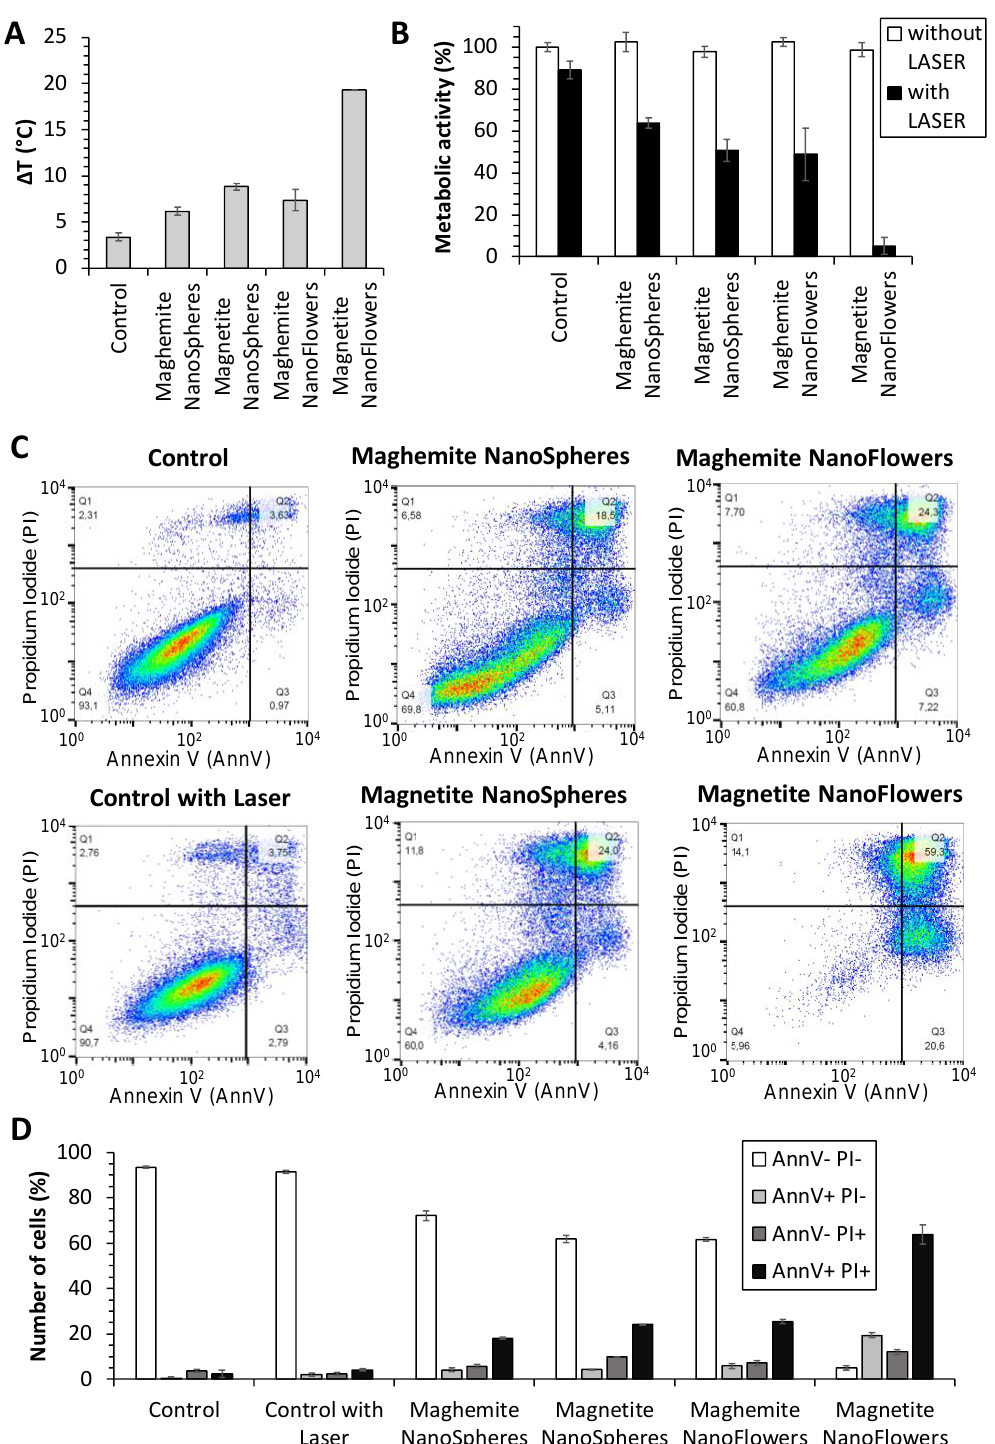
Figure 6. Characterization of the photothermal therapy carried out on PC3 prostatic cancer cells doped with the 4 types of MNPs. Temperature increase achieved in the cell suspensions treated with a 1064 nm laser at a power density of 0.3 W cm − 2 for 10 min ( A ), and the corresponding outcomes, 24 h after the treatment, analyzed by a metabolic / cytotoxicity test ( B ) with and without the laser irradiation. Annexin V / propidium iodide apoptosis assay ( C ) in the same conditions and the corresponding percentage fractions of each group ( D ) plotted according to the positivity of the